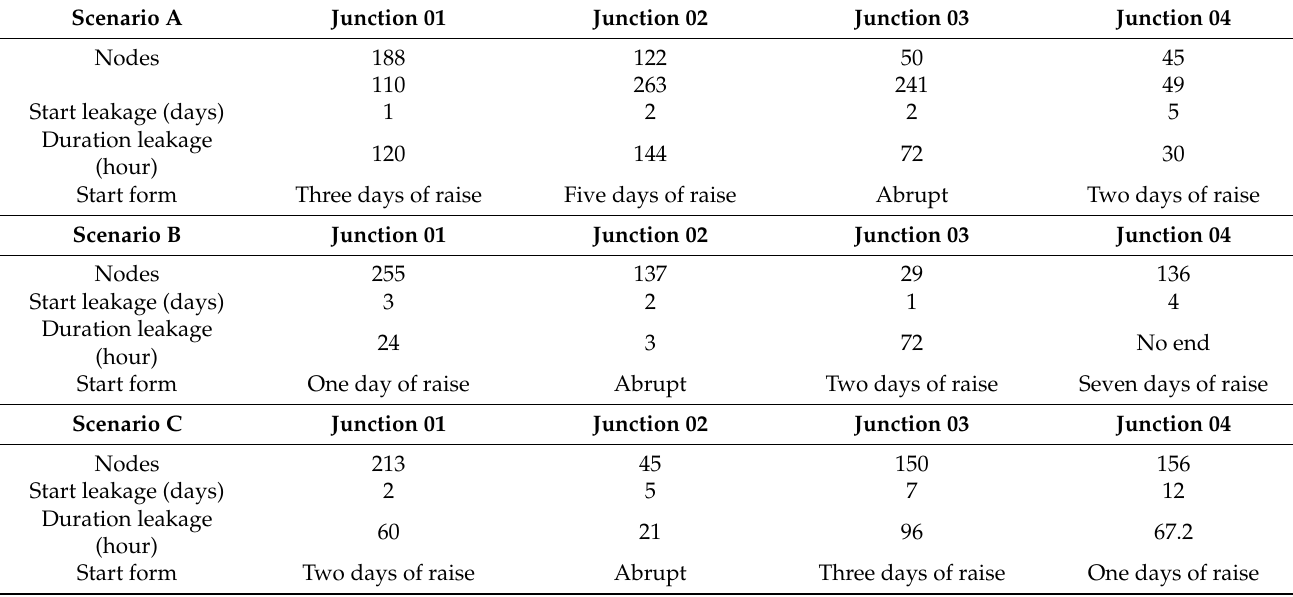
Table 1. Leakage scenarios and